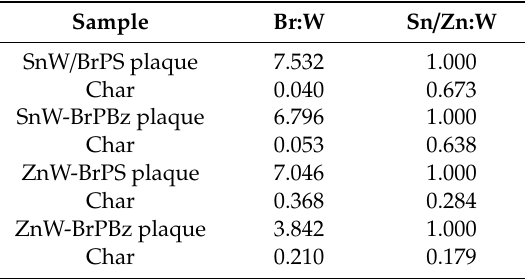
Table 4. Summary of the absolute molar ratios between heavy elements in PA66 plaques and char samples normalised with respect to tungsten present in all samples (W = 1.000). BrPS = brominated polystyrene; BrPBz = poly(pentabromobenzyl aacrylate); SnW and ZnW = tin (II) and zinc tungstates